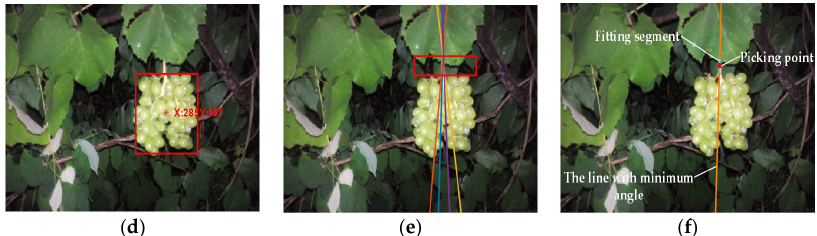
Figure 9. The calculation of the picking point. ( a ) Horizontal line and vertical line; ( b ) detection of line angle range; ( c ) determination of picking point; ( d ) fruit area; ( e ) the region of interest (red box) and the Hough detection results; ( f ) picking-point calculation.